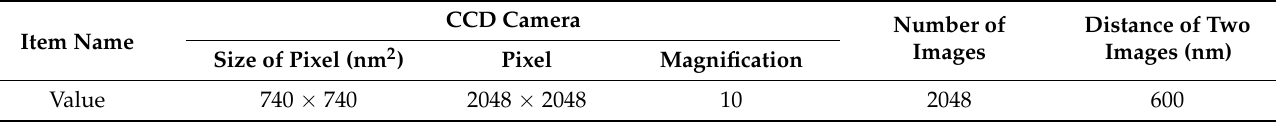
Table 3. Configuration of the X-ray µ CT system at the Shanghai Institute of Applied